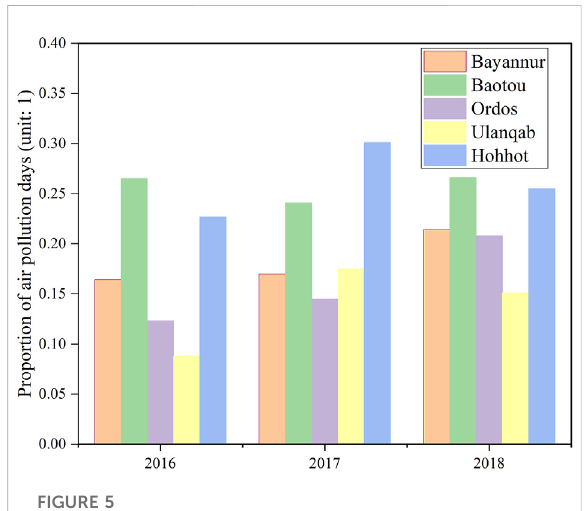
FIGURE 5 Percentage of air pollution days in central Inner Mongolia cities from 2016 to